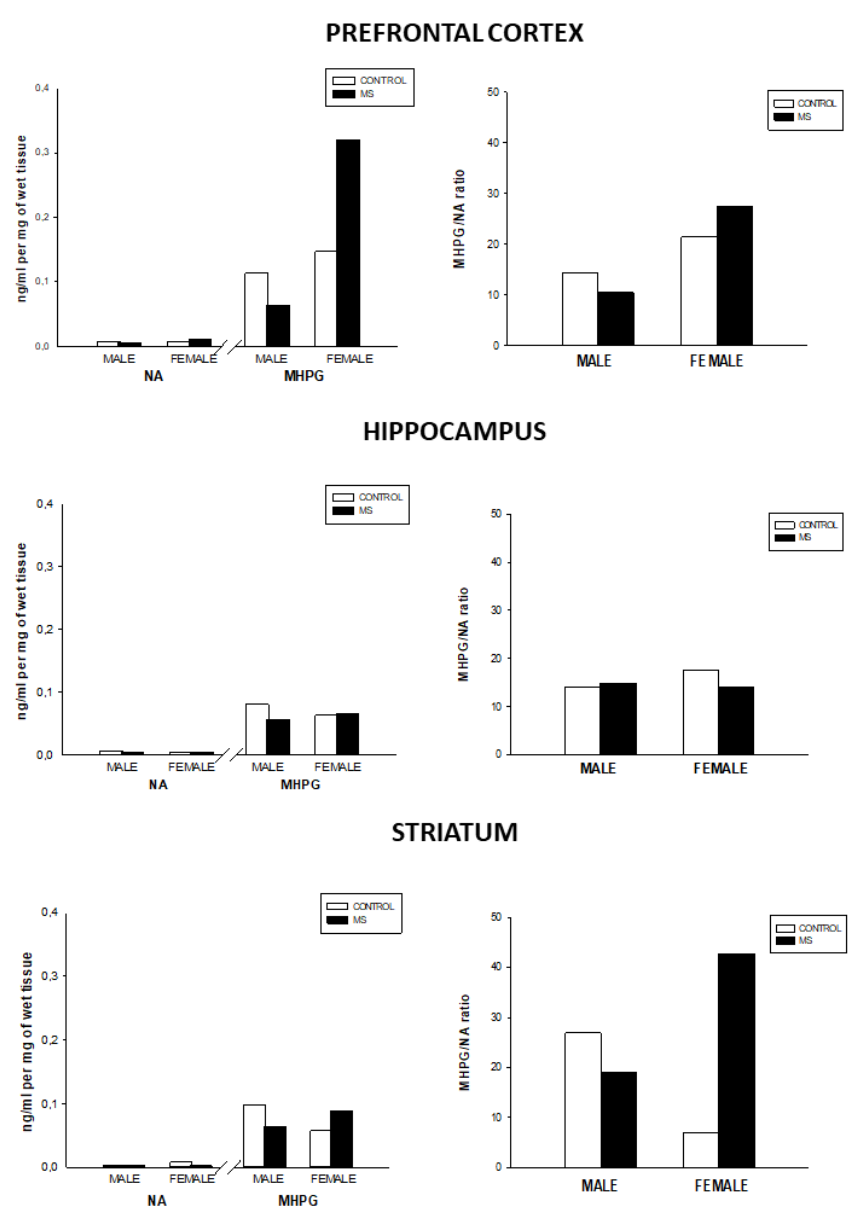
Figure 1. NA, MHPG levels (ng/mL per mg of wet tissue), and NA turnover (MHPG/NA) in the prefrontal cortex, hippocampus, and striatum for the control and MS groups.